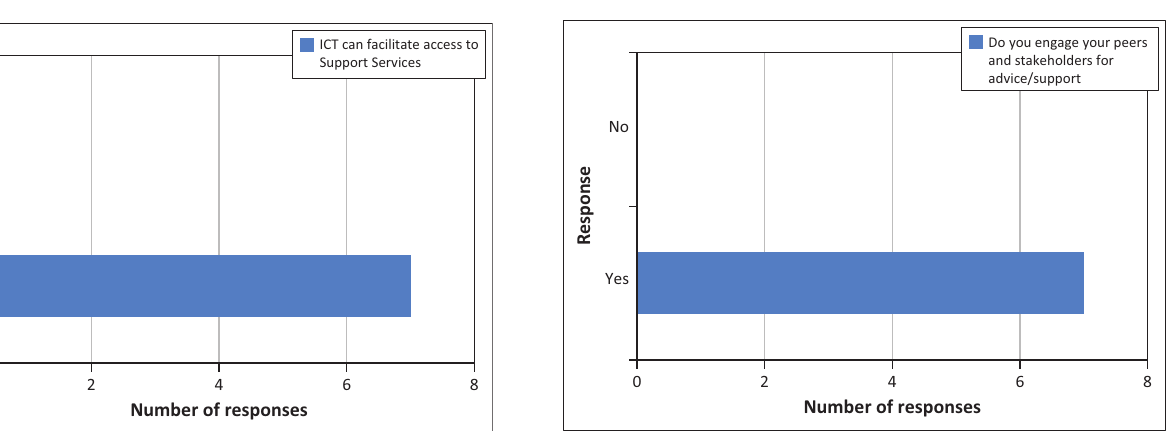
FIGURE 4: Information and Communication Technology use to access support services.